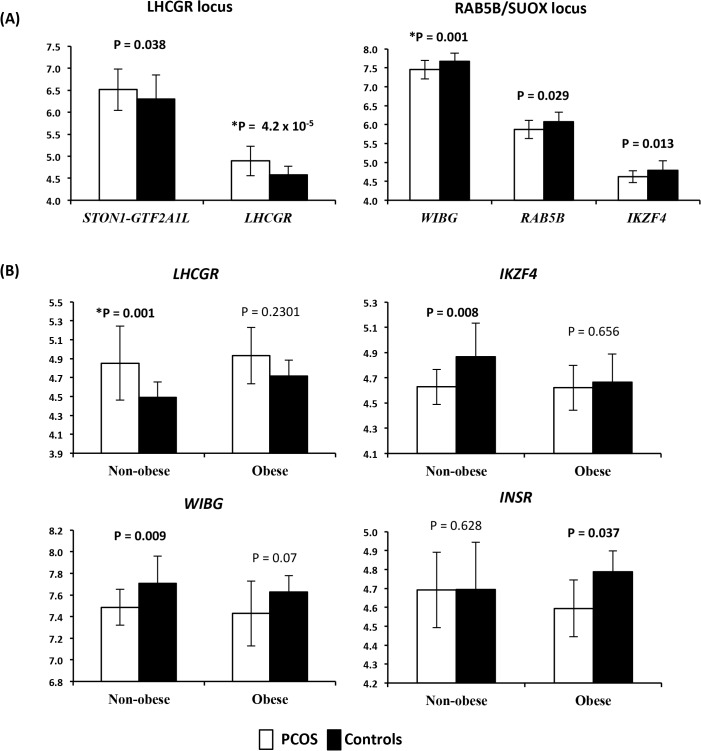
Expression levels of differentially expressed mRNA transcripts.
(A) Expression levels of differentially expressed mRNA transcripts between PCOS and controls in the LHCGR and RAB5B/SUOX loci. On the X axis are gene names. On the Y axis are the mean expression levels. Error bars represent standard deviation. (B) Expression levels of mRNA transcripts differentially expressed between PCOS and controls, stratified by obesity. On the X axis is the obesity status of the subjects, non-obese and obese subjects analyzed separately. On the Y axis are the mean expression levels. * Denotes results that remained significant after correction for multiple testing. Error bars represent standard deviation.